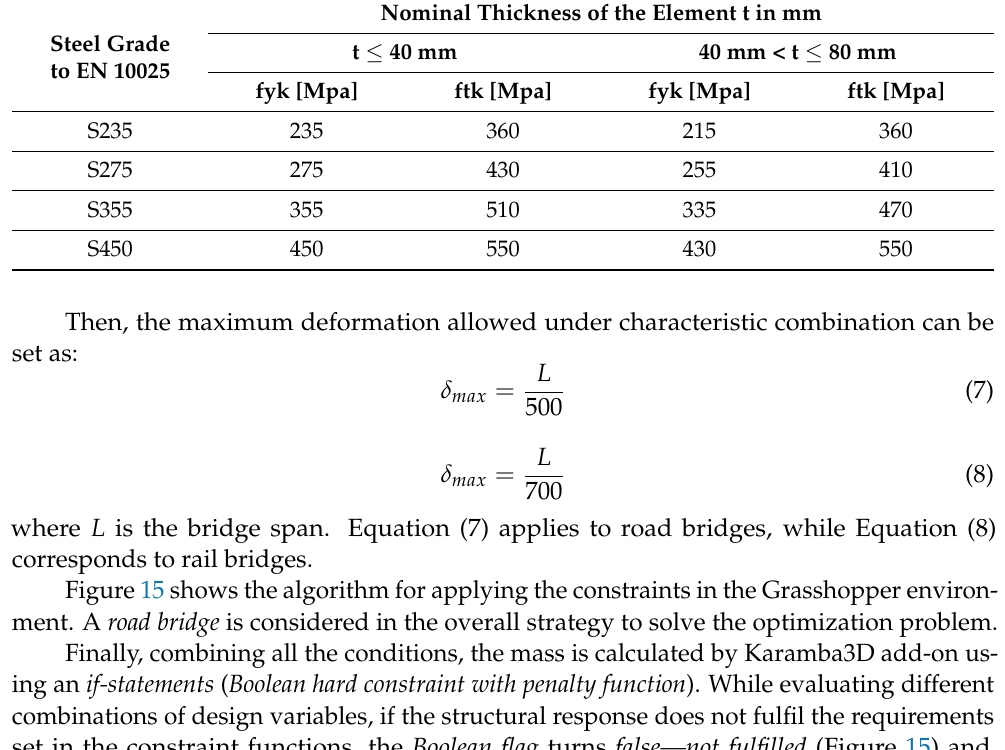
Figure 16. Optimization results plot using Design Explorer 2© .